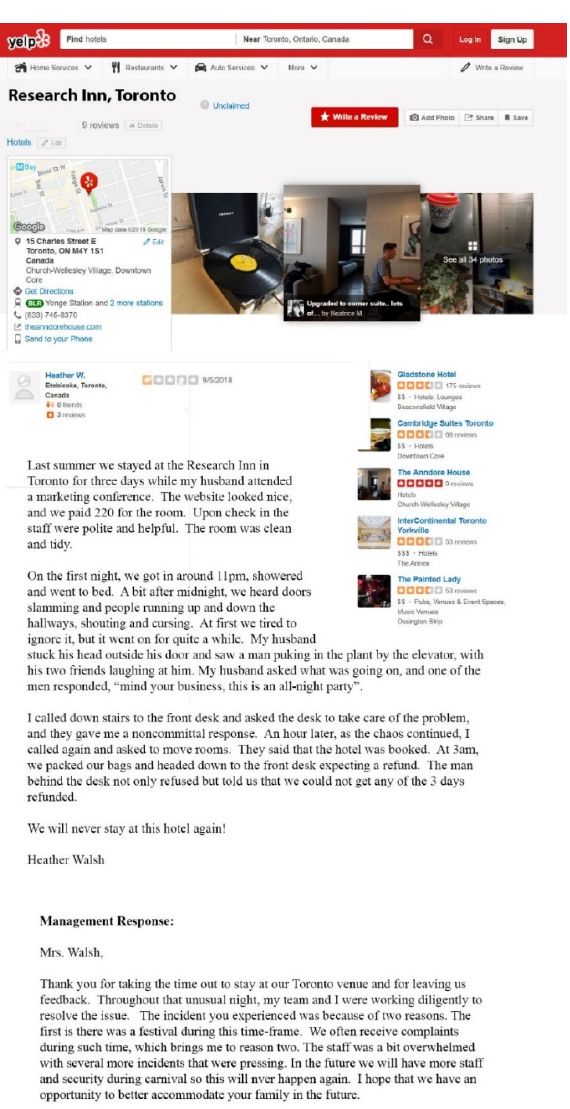
Figure A1. Review with reason and apology.